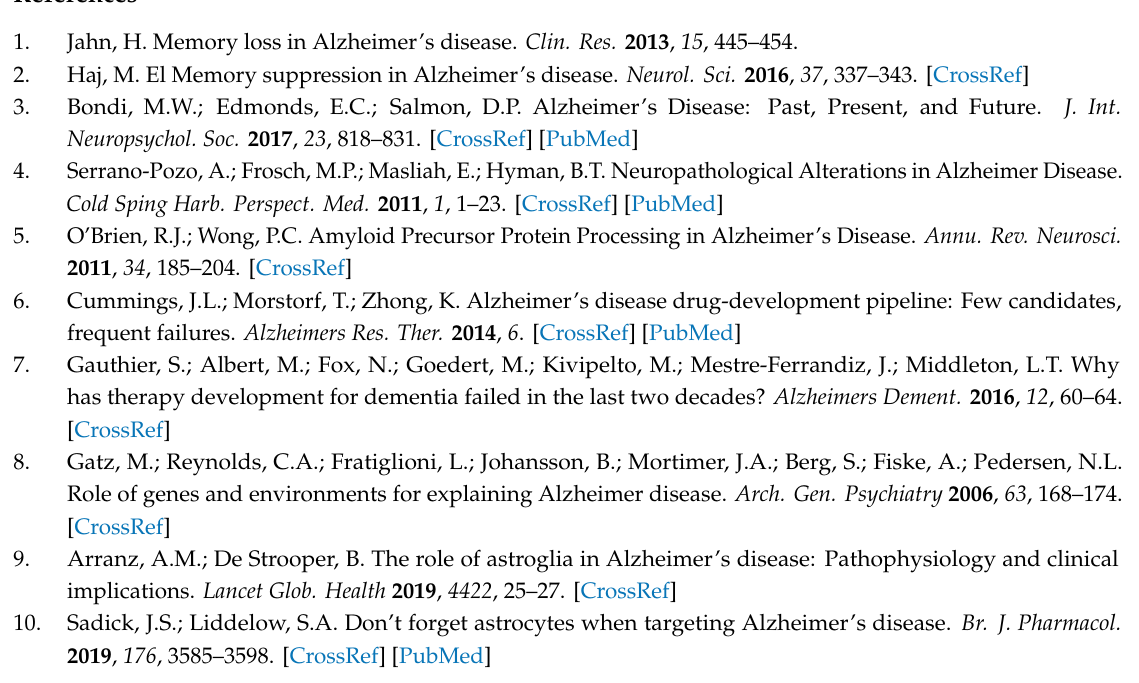
Table S2: Main astrocytic findings from Tau mouse models: MAPT and APP / MAPT / PSEN (3xTg). Table S3: Main astrocytic findings from LOAD and LOAD / FAD mouse models. Supplementary